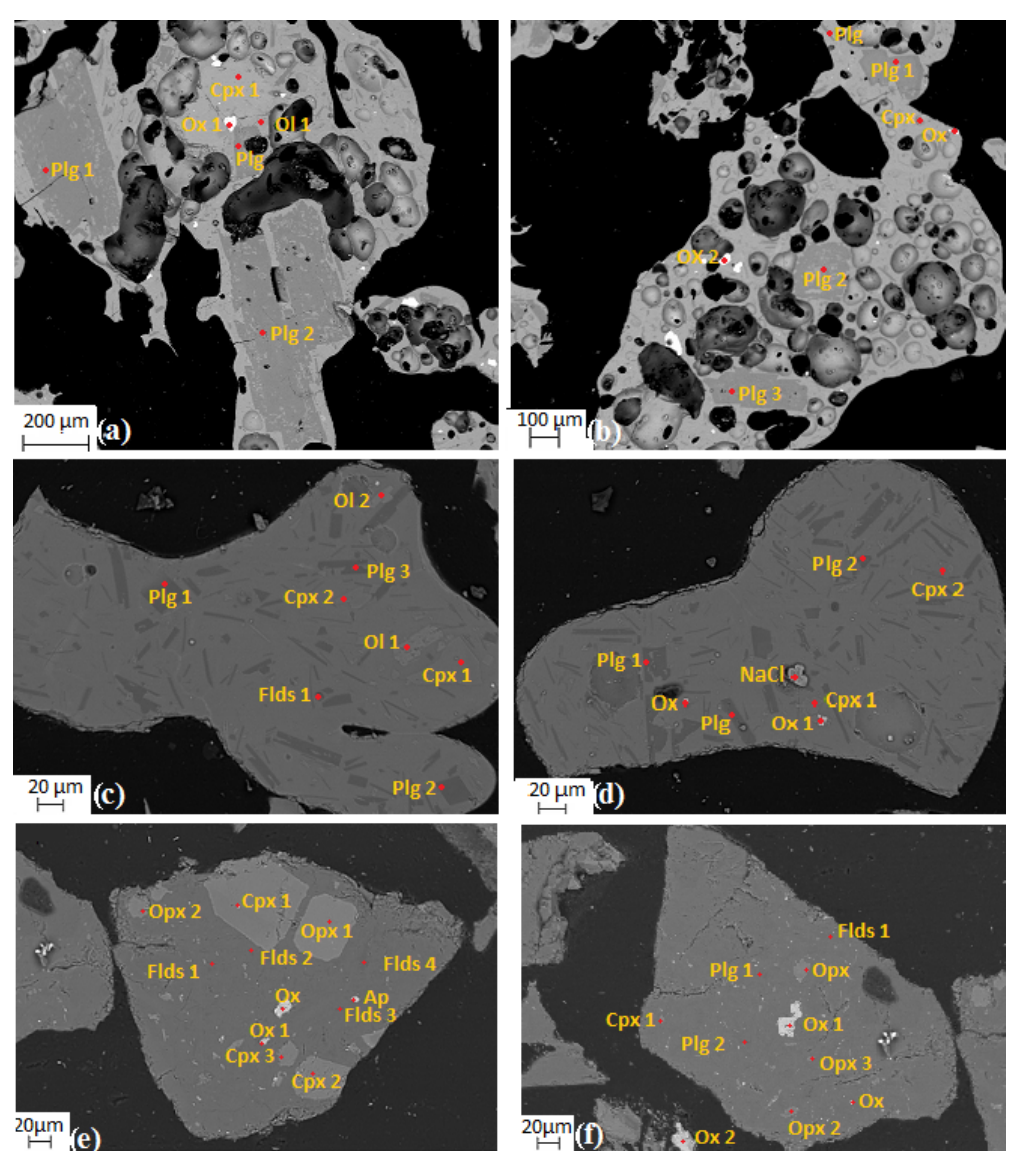
Figure 2. BSE-SEM images of polished particles from Etna 2011 (a, b) , Etna 2012 (c, d) , and Popocatépetl samples (e, f) . Cpx represents clinopyroxene; Opx orthopyroxene; Ox oxide; Plg plagioclase; Ol olivine; Ap apatite; and Flds feldspar.